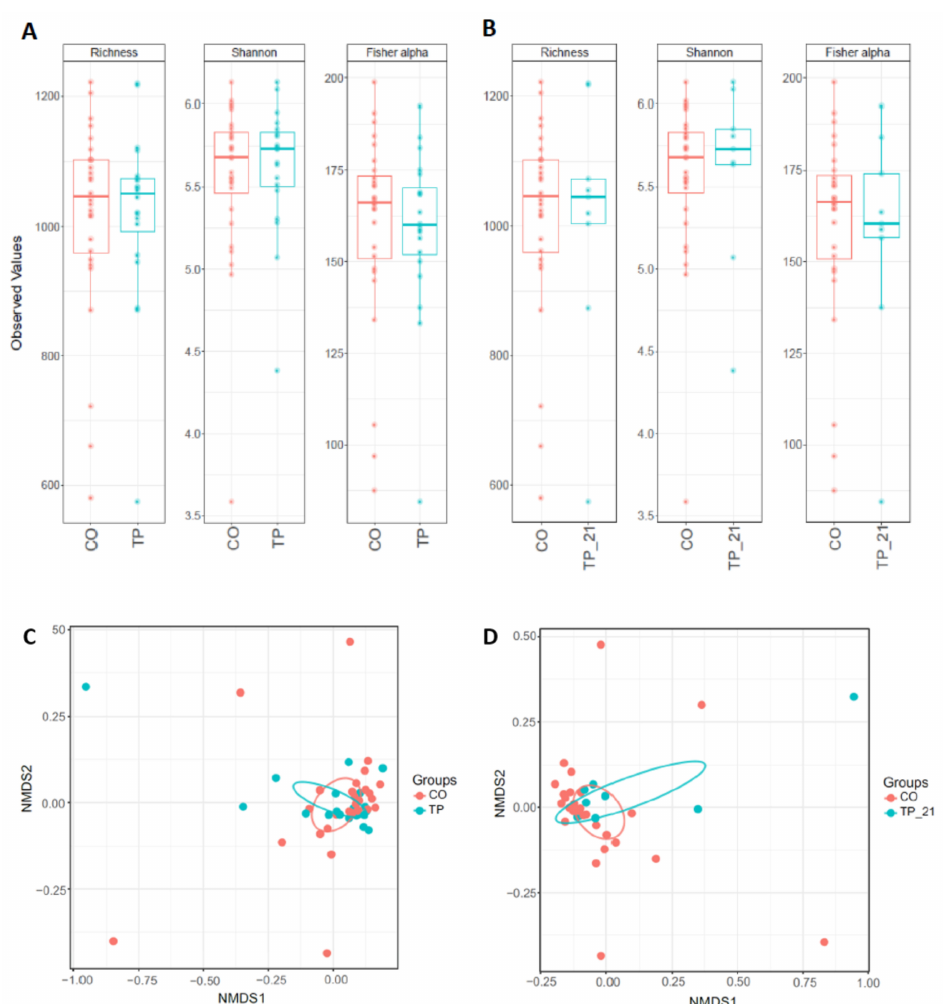
Figure 2. Alpha ( A , B ) and beta diversity (Bray-Curtis distance is shown) ( C , D ) indices (OTU level) of the colonic contents of horses infected with Anoplocephala perfoliata and non-infected controls. Alpha diversity was not significantly different between groups, pair-wise ANOVA ( p > 0.05). The beta diversity between groups was not significant (PERMANOVA, p > 0.05). In ( A , C ) CO (n = 28) vs. TP (n = 20), ( B , D ) CO vs. TP_21 (n = 9). Key: TP = tapeworm positive (n = 20), TP_21 = tape- worm samples with >21 worms (n = 9), CO = control (tapeworm negative), NMDS = non-metric multidimensional